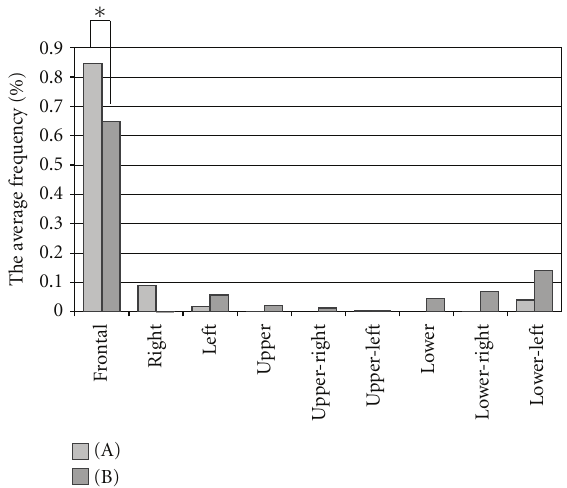
Figure 7: Average frequency of the 9-oriented face orientation ( ∗ P < 0 .